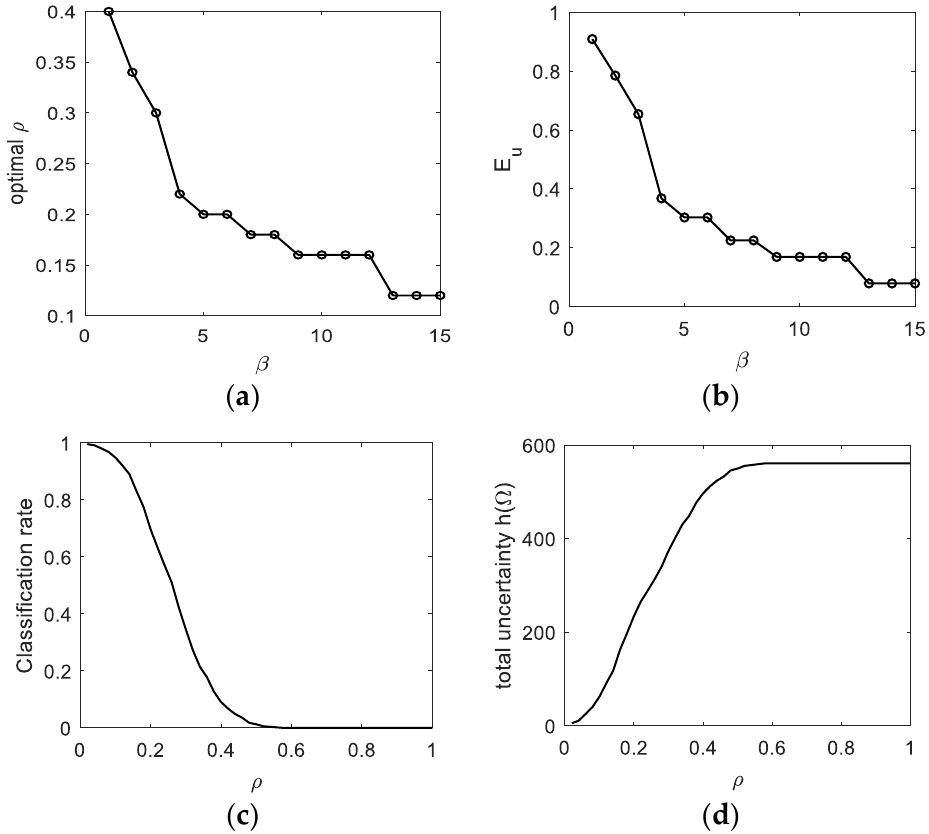
Figure 7. Performance of different parameters in uncertain granule construction. ( a ) optimal ρ vs β ; ( b ) E ur vs. β ; ( c ) classification rate vs. ρ ; ( d ) uncertainty h ( Ω ) vs. ρ .